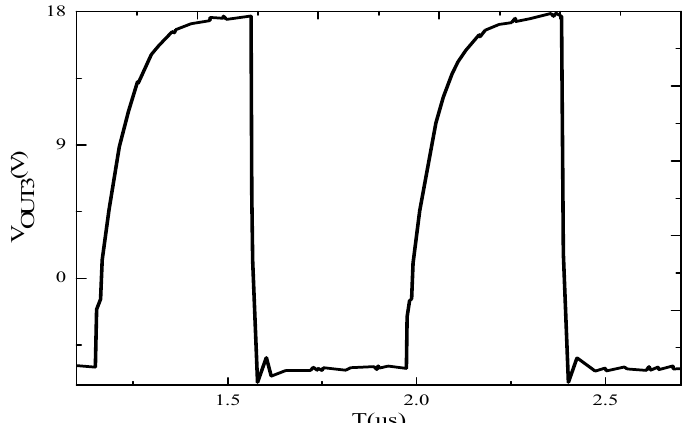
Figure 9. The experimental output (V OUT3 ) for the left side of the gate driver where the bias voltage (V DD2 ) of the left side for the 3rd stage is 18.5 V.